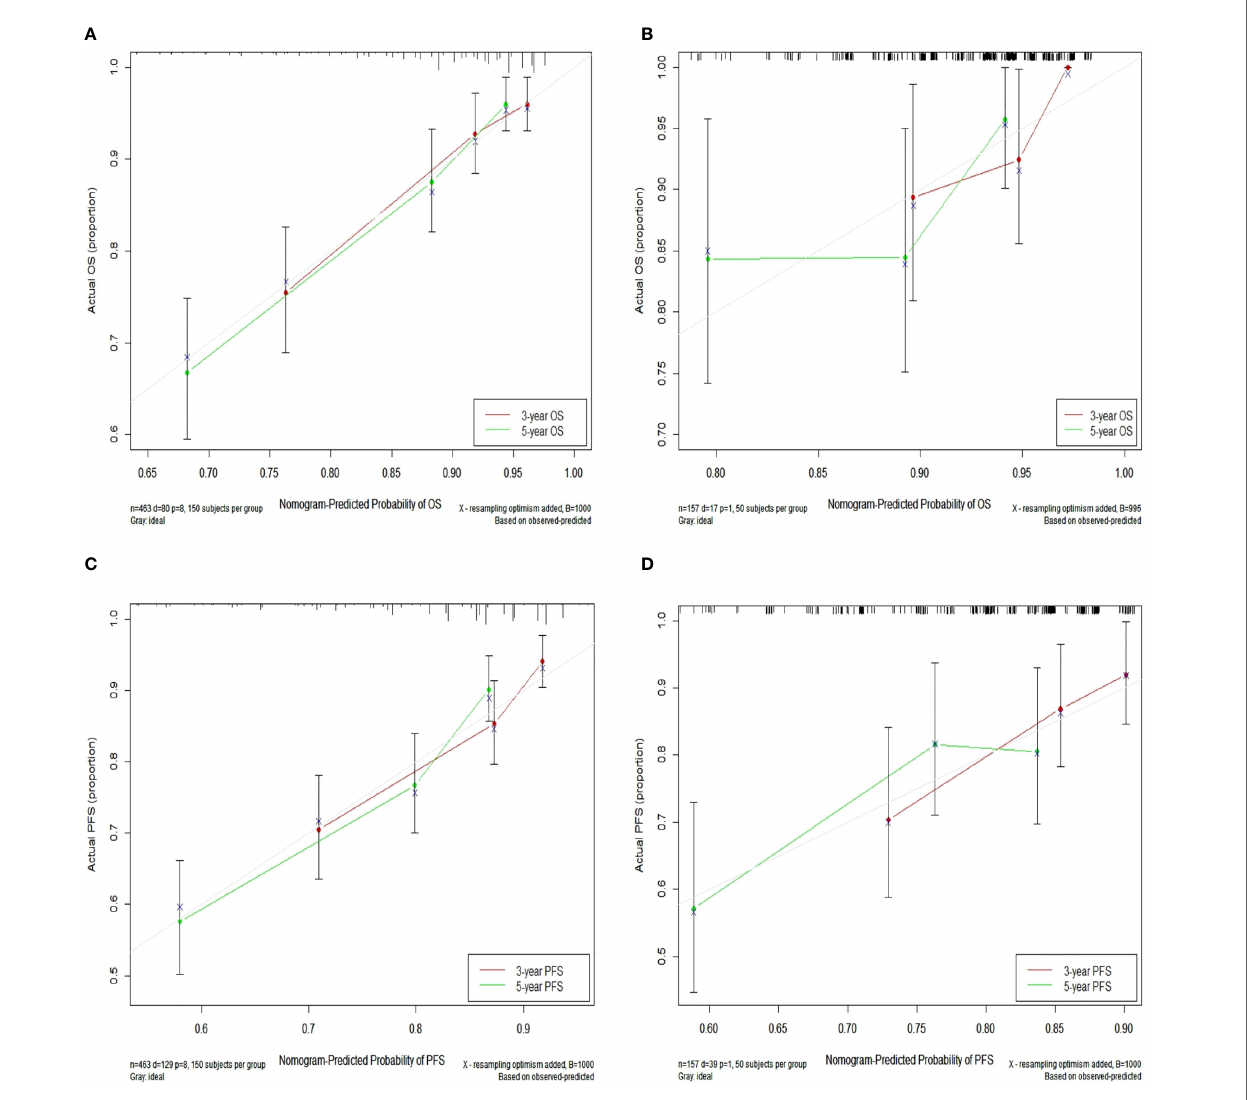
FIGURE 4 | Calibration curves for 3- and 5-year OS in the training set (A) and calibration curves for 3- and 5-year OS in the validation set (B) ; Calibration curves for 3- and 5-year PFS in the training (C) and validation (D) sets. Nomogram-predicted OS and PFS are plotted on the x-axis; actual OS and PFS are plotted on the y- axis. Dashed lines along the 45-degree line passing through the point of origin represent perfect calibration models in which predicted probabilities are identical to actual probabilities. OS, overall survival; PFS, progression-free